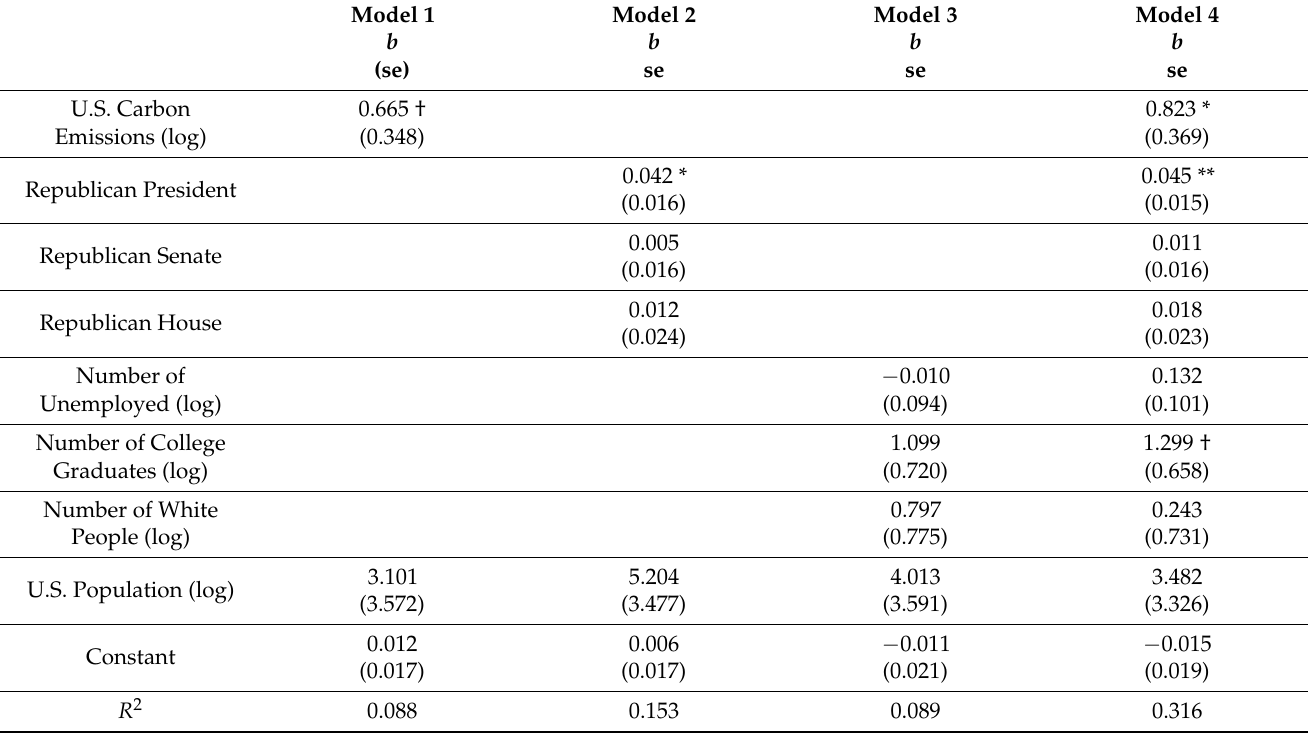
Table 3. Estimates of First-Differenced Determinants of Sierra Club Members, 1960–2016 1 . Model